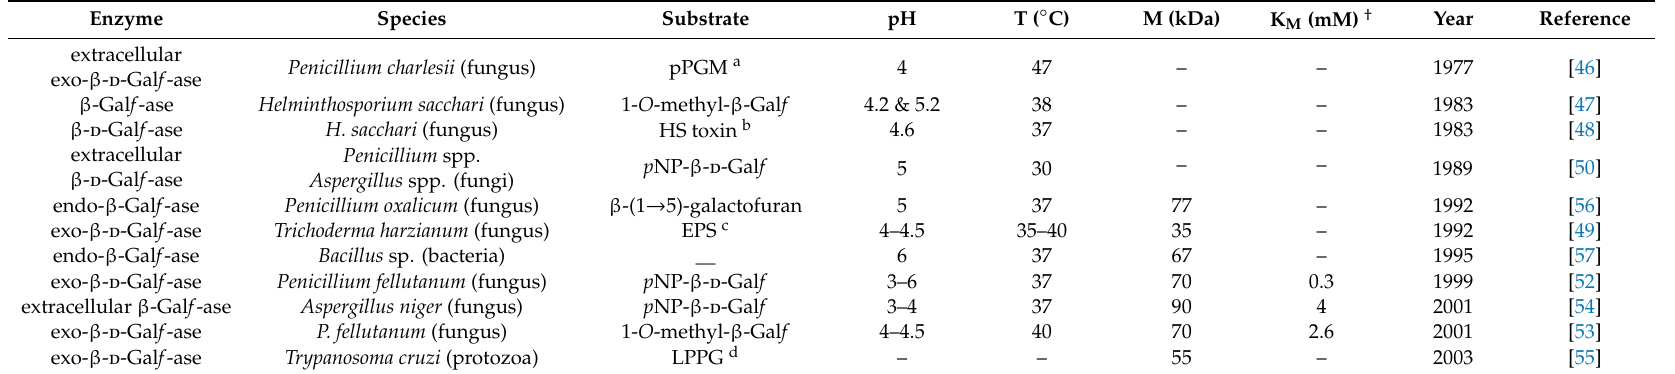
Table 1. Comparative properties of β - d